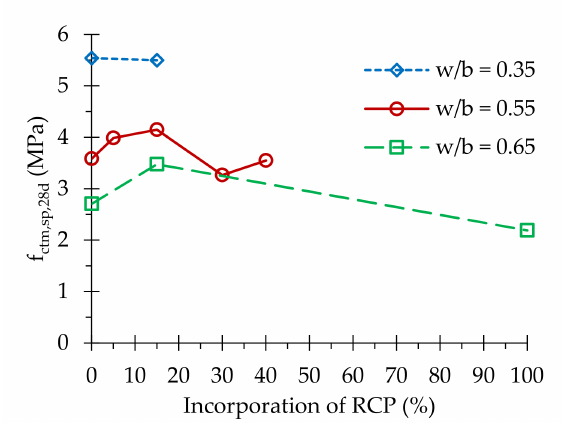
Figure 15. Tensile splitting strength at 28 days, f ctm , sp ,28 d , of concrete with different incorporation percentages of RCP and w/b.